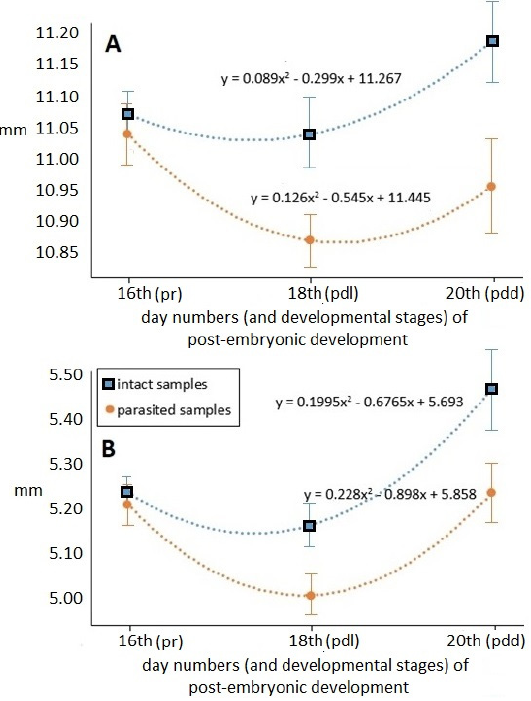
Figure 4. Tendency of the measured longitudinal parameters (mean ± SE) as a function of the different times of post-embryonic honey bee development. ( A ): total-body length; ( B ): abdomen length; pr, pdl, pdd: ontogenetic stages of worker bee development, following [ 26,31]; R 2 = uniformly 1.